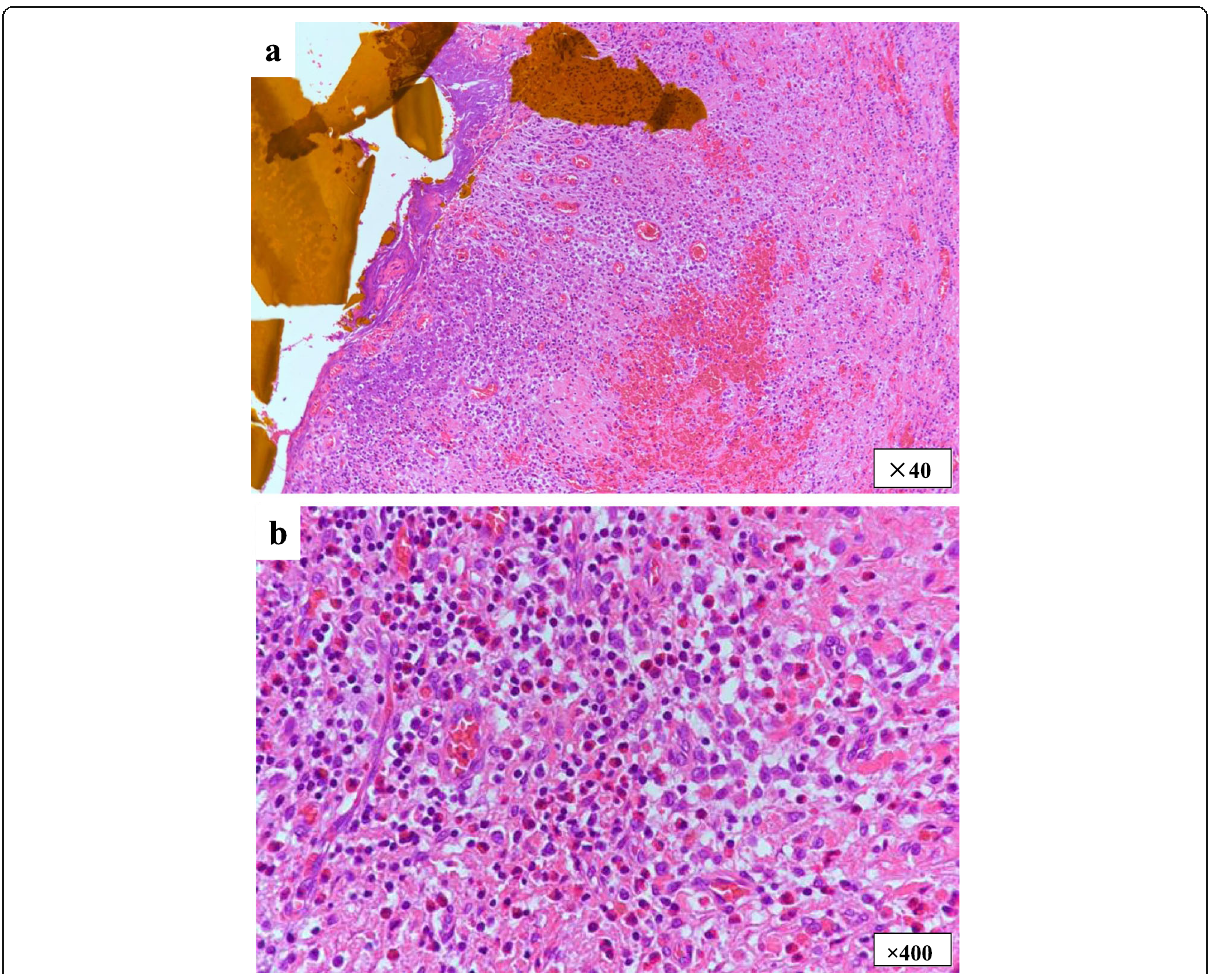
Fig. 3 Pathological findings of the common bile duct. The submucosa of the common bile duct was diffusely infiltrated by a mixture of eosinophils and histiocytoid cells characterized by grooved and convoluted nuclei with scattered chromatin